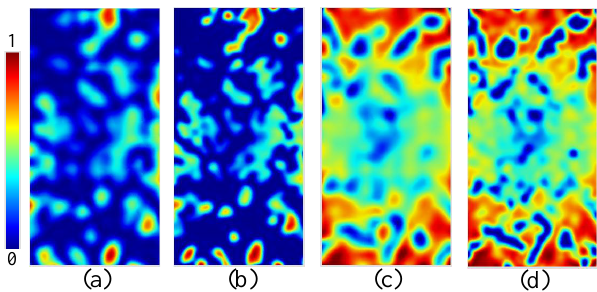
Figure 20. Damage responses at t = 36 µ s for the domain with l c = 5 mm with different meshes and load amplitudes: ( a ) low amplitude-medium mesh, ( b ) low amplitude-fine mesh, ( c ) high amplitude-medium mesh, and ( c ) high amplitude-fine